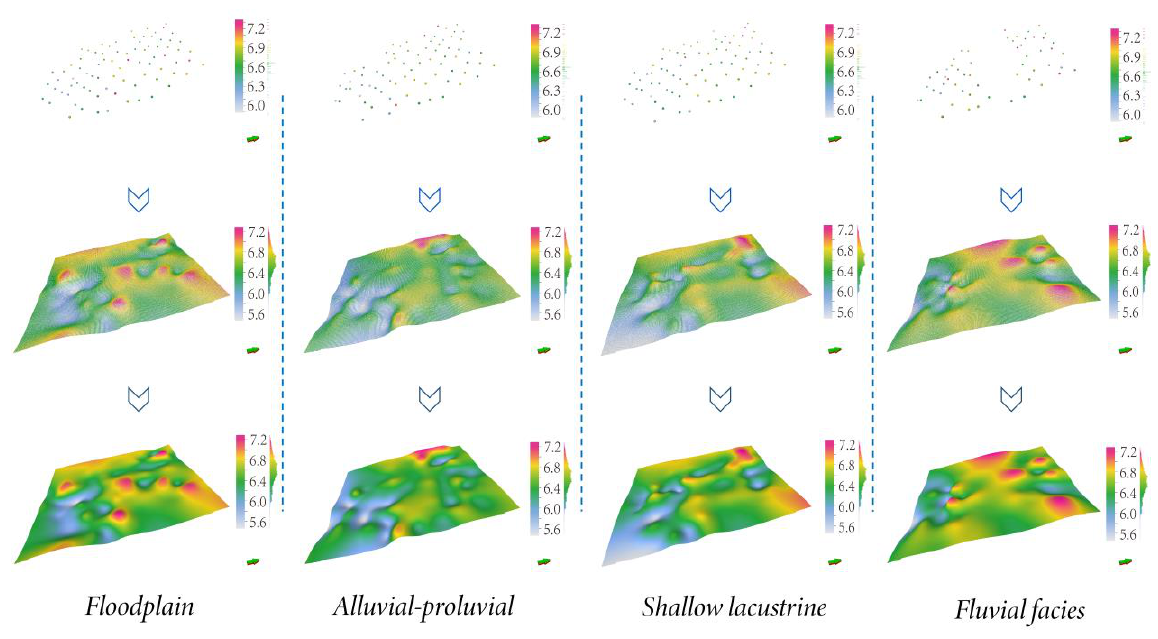
Figure 7. Establishing the 3D geological model of Quaternary loose sedimentary strata of the citizen center based on the global strata discrete points. Vertical exaggeration = 25×.